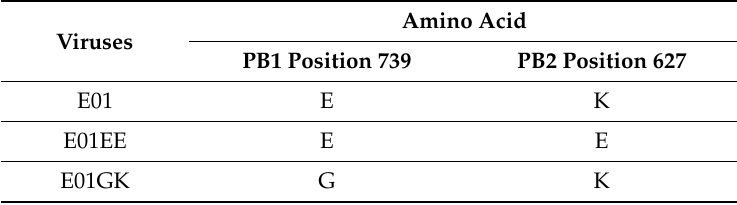
Table 1. The amino acid divergences among A / canine / Taiwan / E01 / 2014 (E01) and its derivatives E01EE and